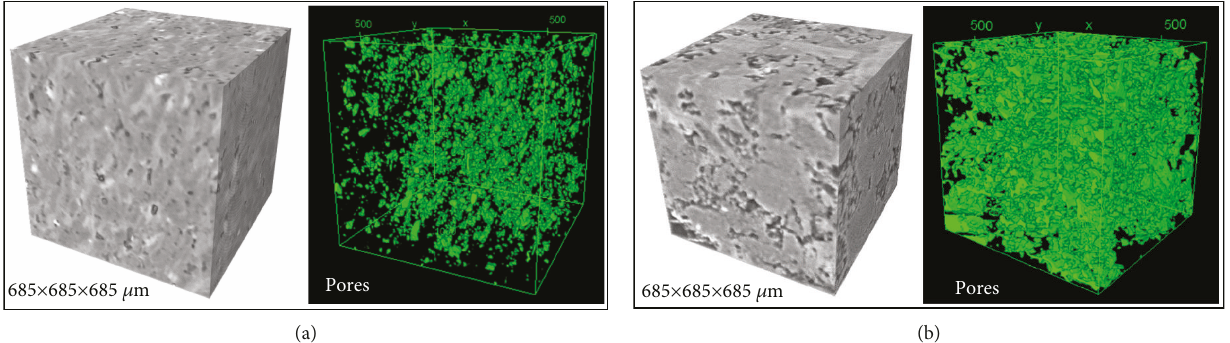
Figure 13: X-ray microCT 3D images of the main types of fault cores found in the study areas: (a) sand-rich fault core and (b) clay-rich fault core (characterized by clay smearing). The samples come from the same fault, which is located at the Sassoscritto area. The grey images correspond to the rendering of the 3D X-ray microCT images, whereas the green volumes to the right are the segmented pore